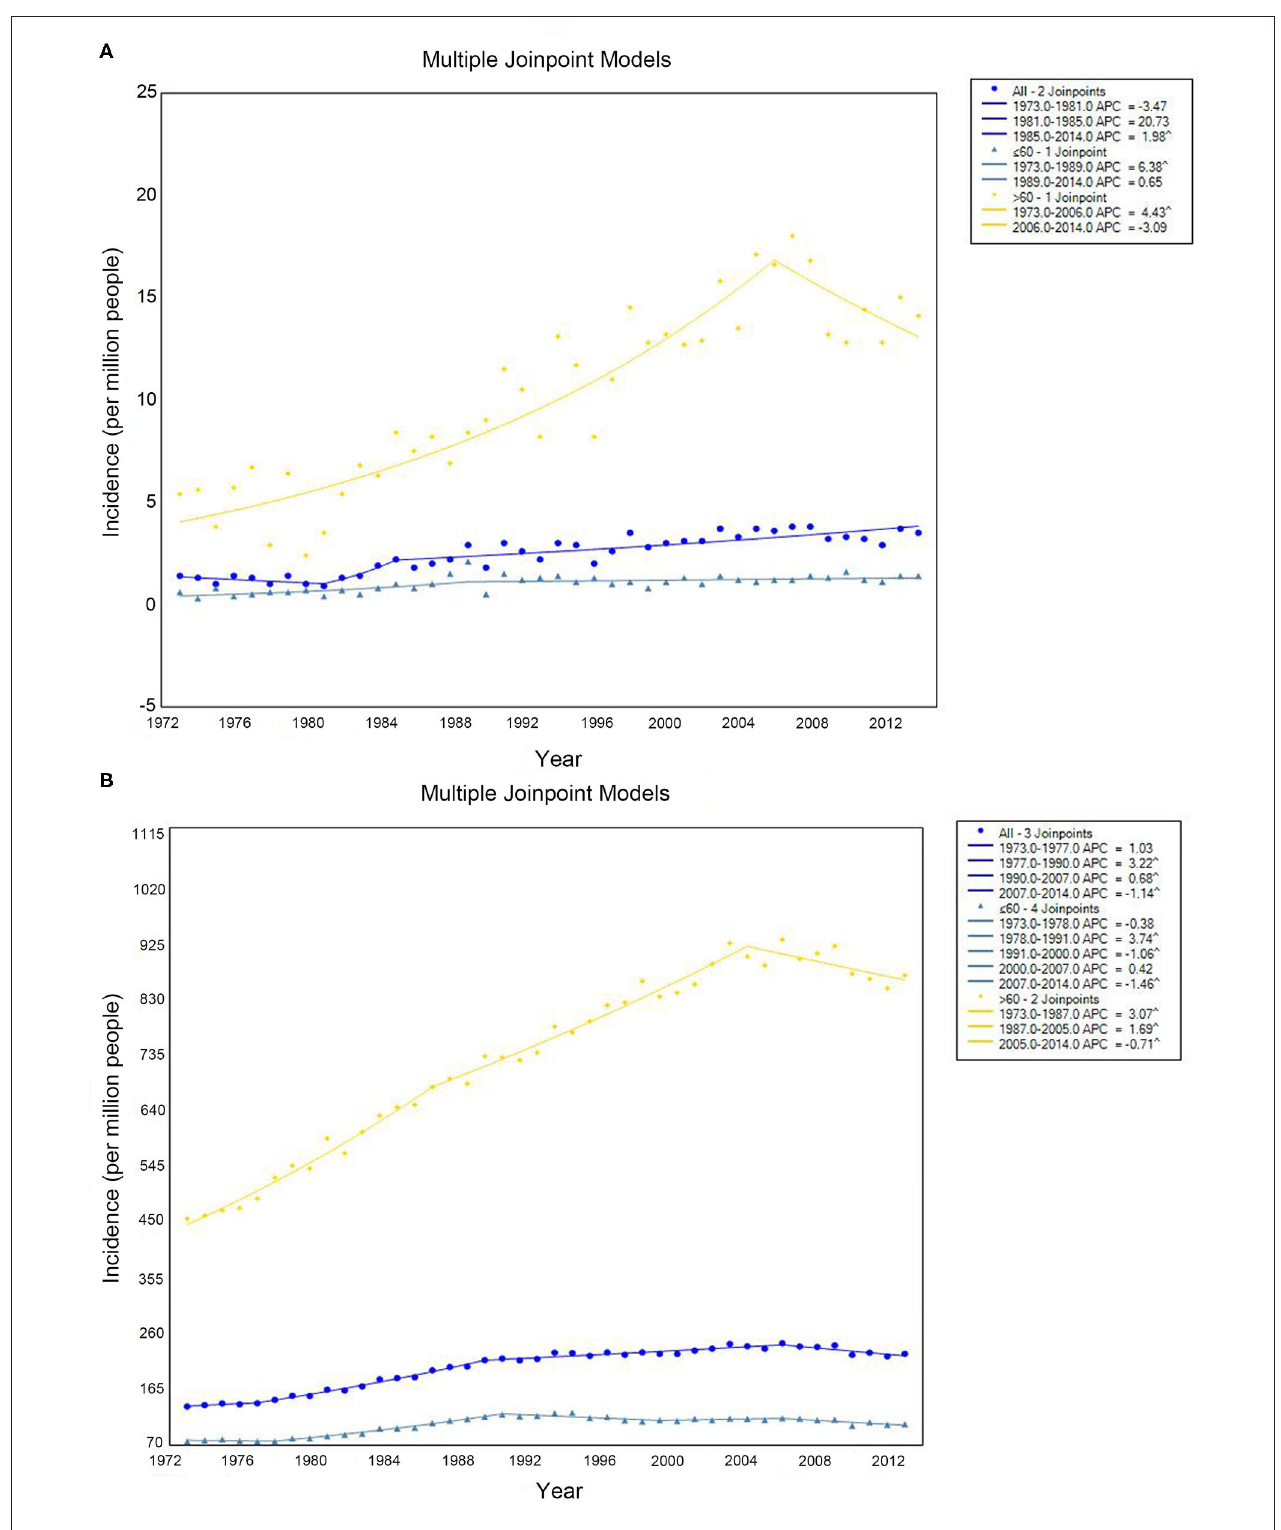
FIGURE 1 | Incidence of primary colorectal lymphoma (A) and total lymphoma (B) by age. Incidence (per 1 000 000 persons) was calculated in SEER 9 registries, 1973–2014.